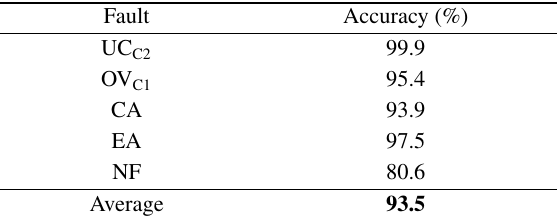
Table 8 Fault accuracy of Method 1.